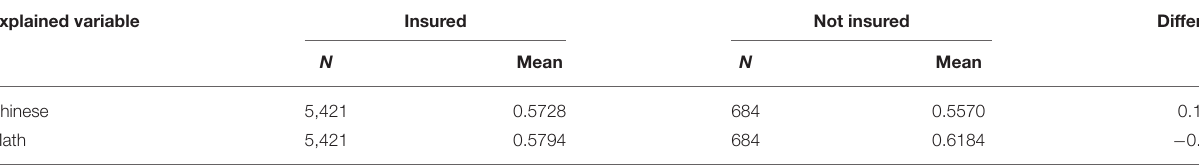
TABLE 1 | Descriptive statistics of the explained variable.